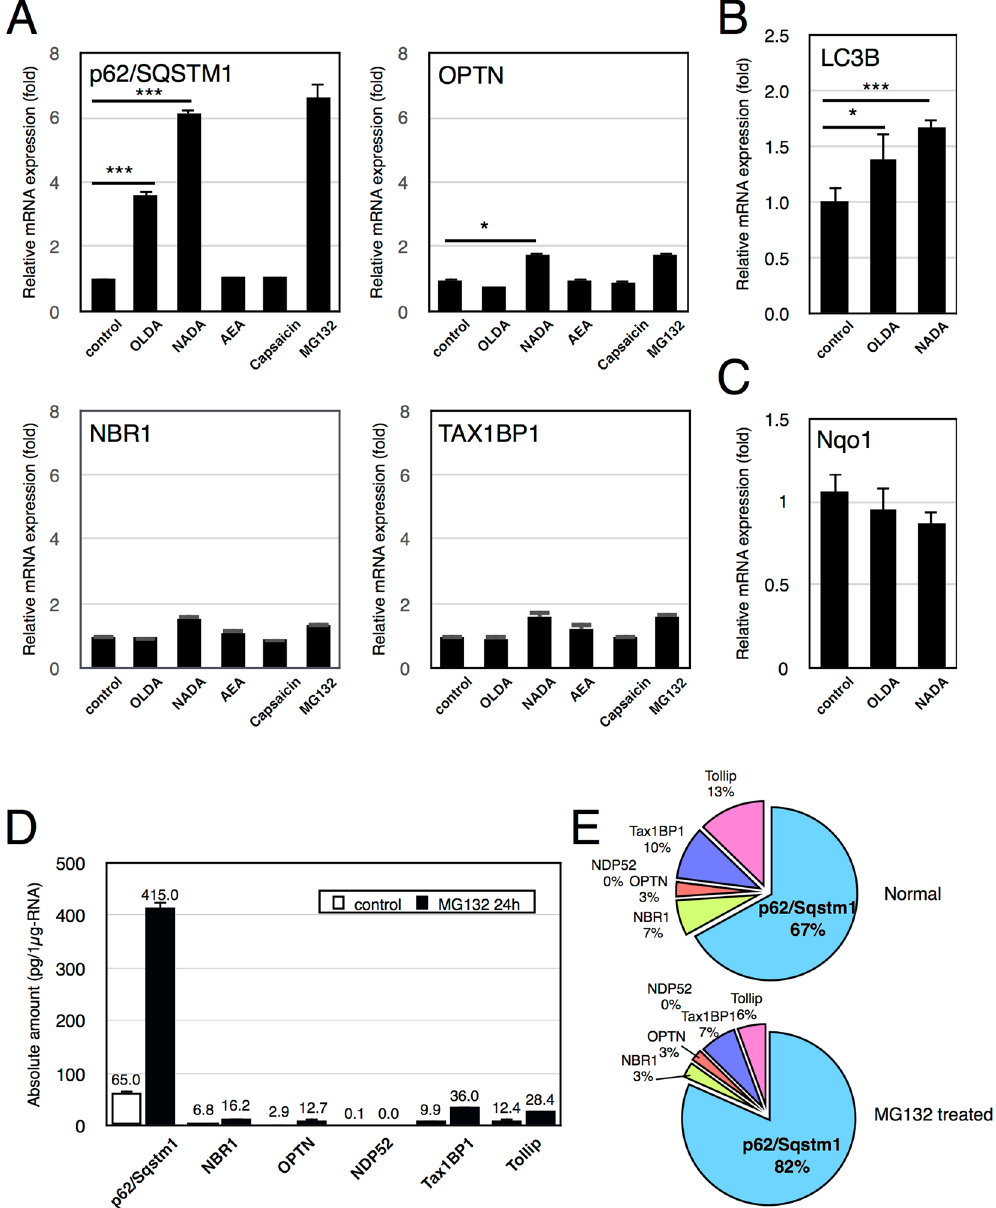
Figure 5. AcylDA induce p62 expression in transcription level but does not affect the expression of other autophagy receptors. ( A ) Relative mRNA levels of autophagy receptors in N2a cells treated with 5 µ M OLDA, 5 µ M NADA, 10 µ M anandamide (AEA), 50 µ M capsaicin (Caps), or 1 µ M MG132 for 12 h as indicated were measured by quantitative RT-PCR (qPCR) analysis. mRNA amounts of each autophagy receptor were normalized to Gapdh. ( B ) Relative mRNA level of LC3B in N2a cells treated with 5 µ M OLDA or 5 µ M NADA for 24 h was measured by qPCR and normalized to Gapdh. ( C ) Relative mRNA levels of Nqo1 in N2a cells treated with 5 µ M OLDA or 5 µ M NADA for 12 h were measured by quantitative RT-PCR and the amount was normalized to Gapdh. Error bars represent SEM (n = 4), and p-value (Student’s t -test) is shown. * and *** represent p < 0.05 and p < 0.01 ( D ). Total RNAs were prepared from N2a cells treated with or without 1 µ M MG132 for 24 h. The absolute amounts of mRNA of autophagy receptors in 1 µ g-total RNA of N2a cells were calculated by quantitative RT-PCR analysis. GFP-fused autophagy receptor plasmids were used as quantification standards and each plasmid amount was normalized to the copy number of the GFP gene. Gapdh mRNA was 2.05 ± 0.78 ng/ µ g-RNA of N2a cells. The mRNA amounts (pg/ µ g-total RNA) of each autophagy receptor are shown. ( E ) Ratio of mRNA content of ubiquitin-dependent autophagy adapters in